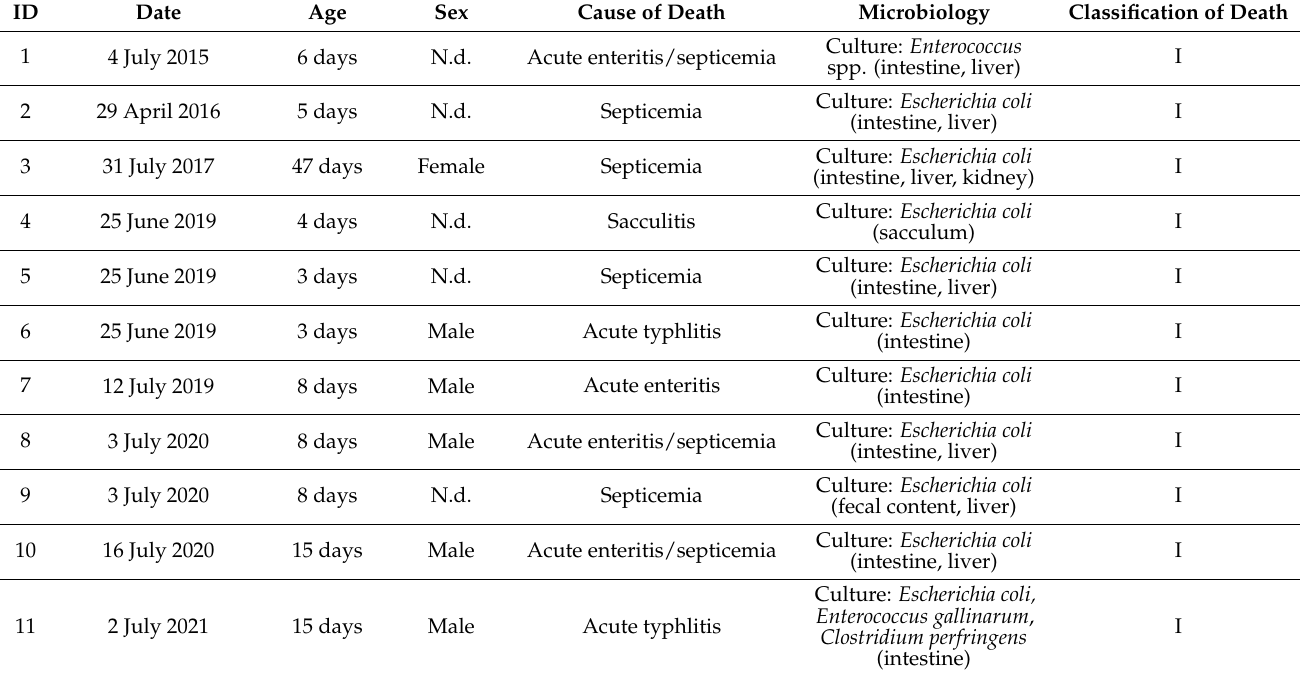
Table 1. Available data, cause of death, and classification of death in young captive Cantabrian capercaillies ( Tetrao urogallus cantabricus ) necropsied in